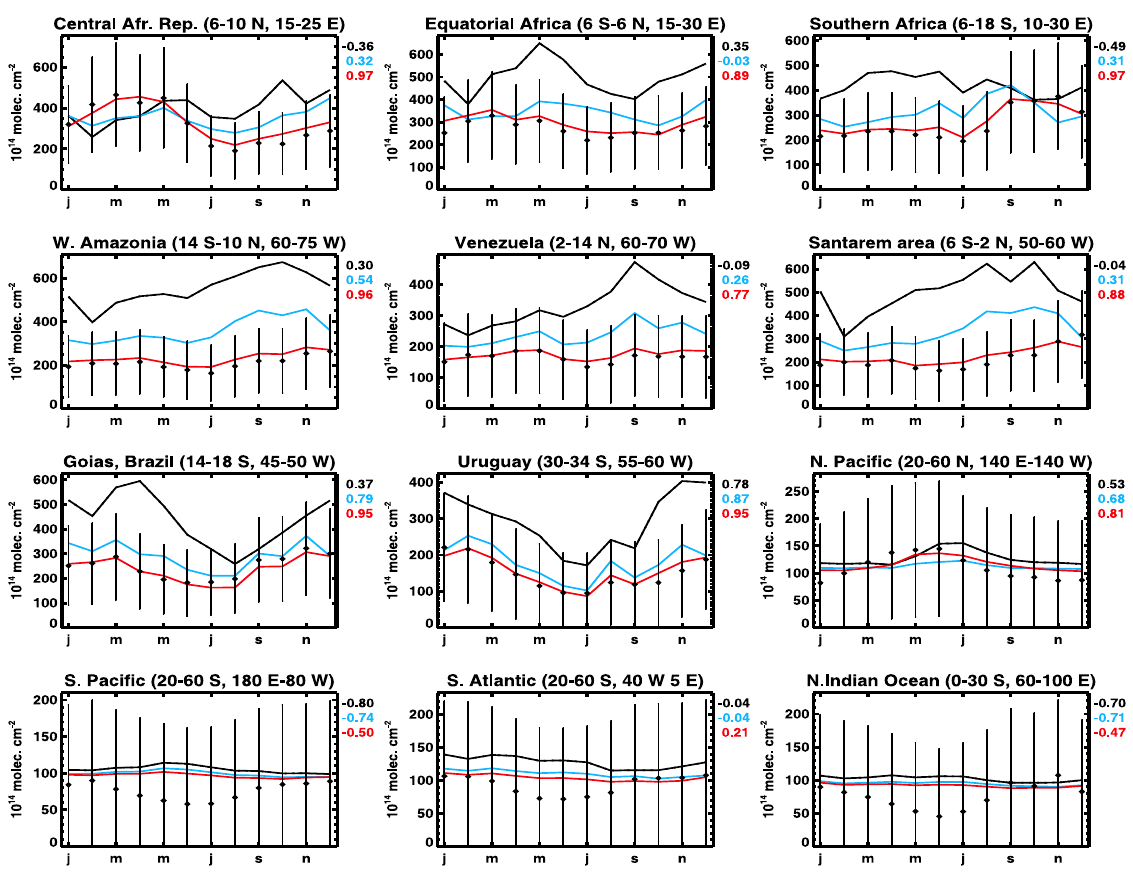
Fig. 6. As in Fig. 5 but for tropical and oceanic regions.